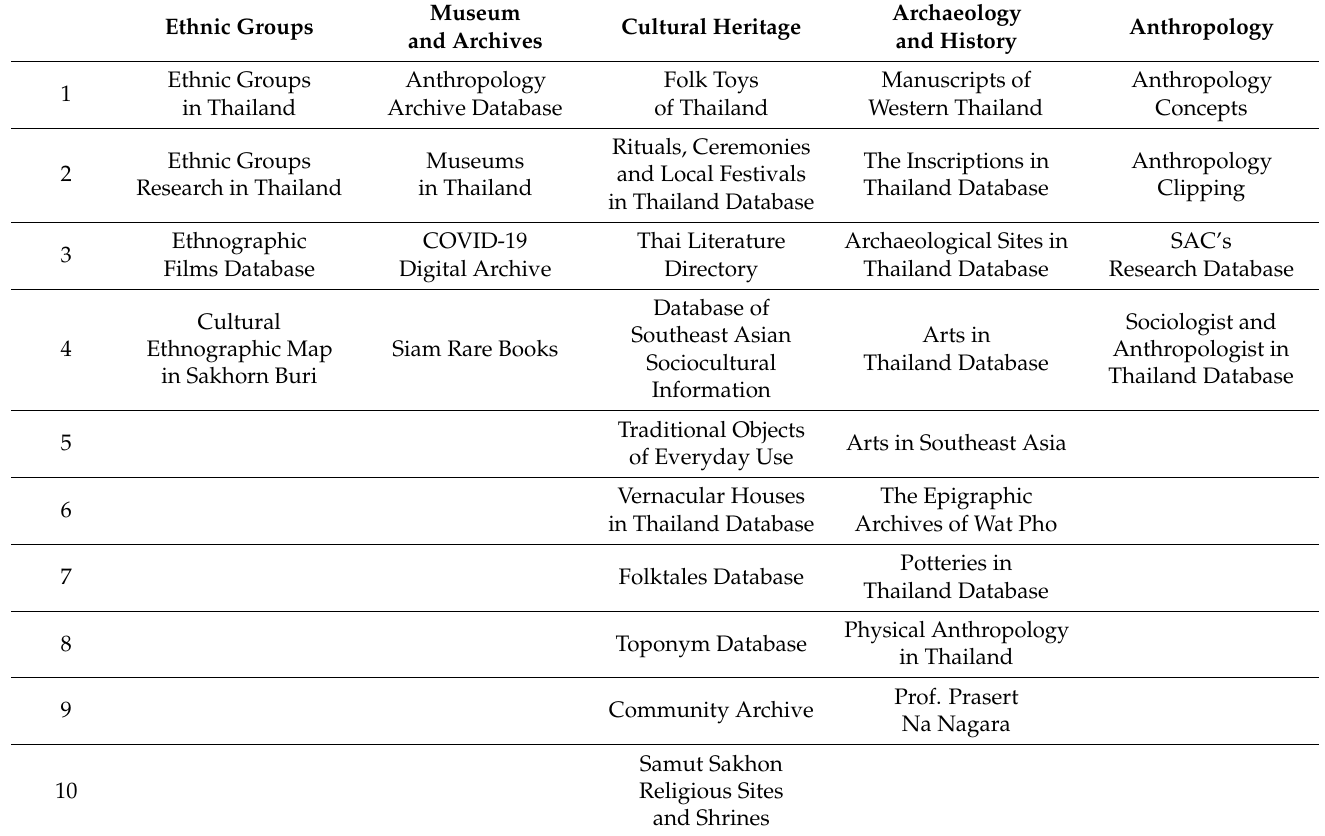
Table 1. Groups of anthropology digital repositories of